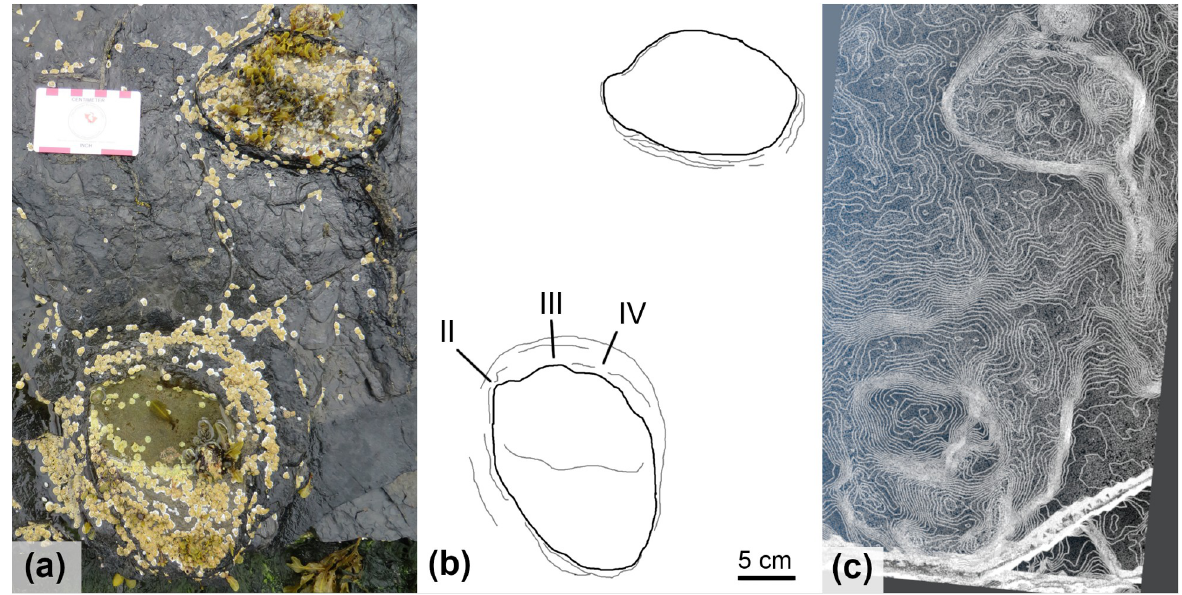
Fig 7. Exemplar manus/pes pair from BP1_Twy_01 at BP1. (a) Field photograph, (b) outline drawing, and (c) contour map of a right manus/pes pair from BP1_Twy_01 highlighting the sediment deformation around each track.